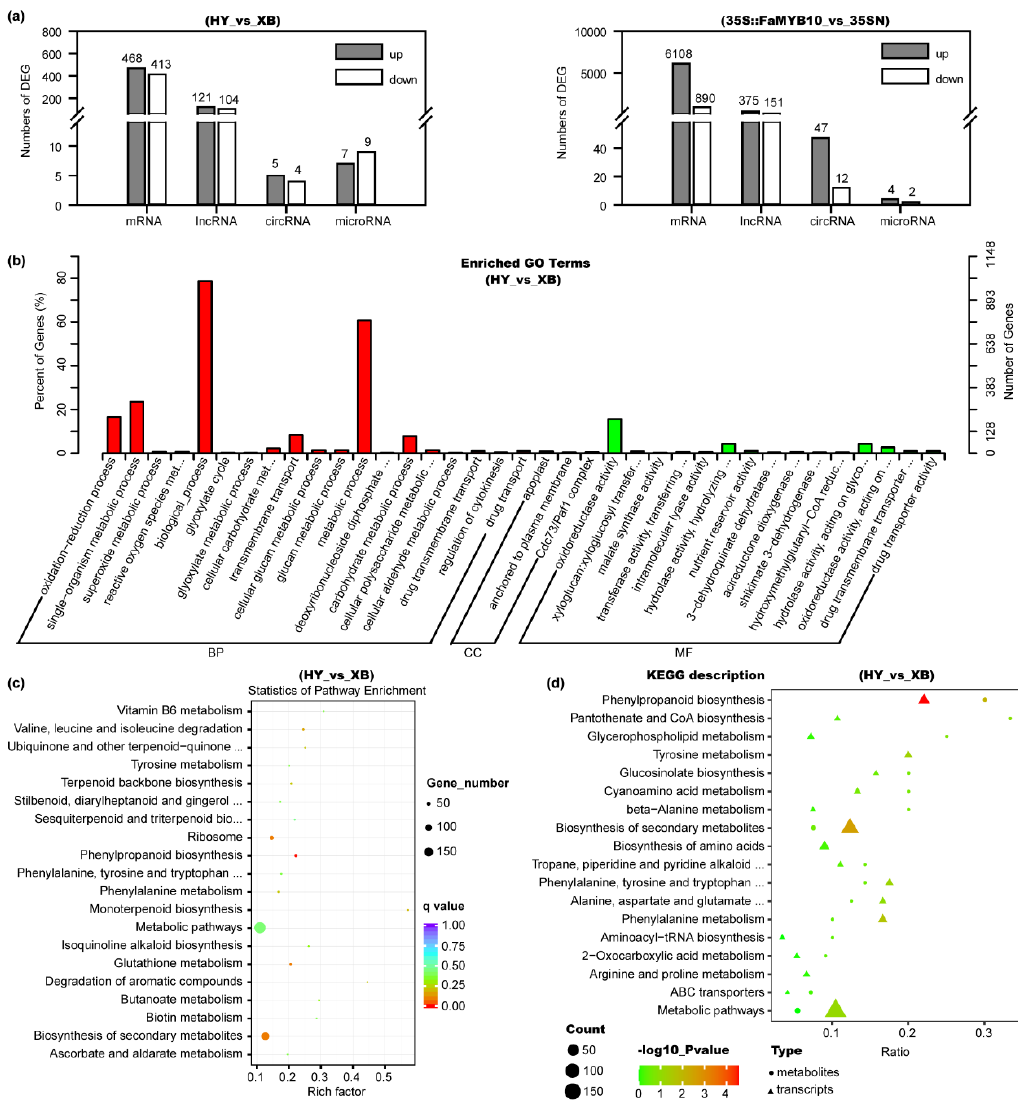
Figure 3. Analysis of the differential metabolites and genes in the flesh of Benihoppe (HY), Xiaobai (XB), 35S::FaMYB10, and 35SN by targeted metabolomics, quasi-targeted metabolomics, and whole transcriptomic sequencing assays. ( a ) Numbers of differentially expressed mRNAs, lncRNAs, circRNAs, and microRNAs in Benihoppe vs. Xiaobai and 35S::FaMYB10 vs. 35SN. ( b ) Function analysis of the DEGs in Benihoppe vs. Xiaobai by Gene Ontology (GO). ( c ) KEGG analysis of the DEGs in Benihoppe vs. Xiaobai. ( d ) Combined analysis of the quasi-targeted metabolomics and transcriptomics in Benihoppe vs. Xiaobai.